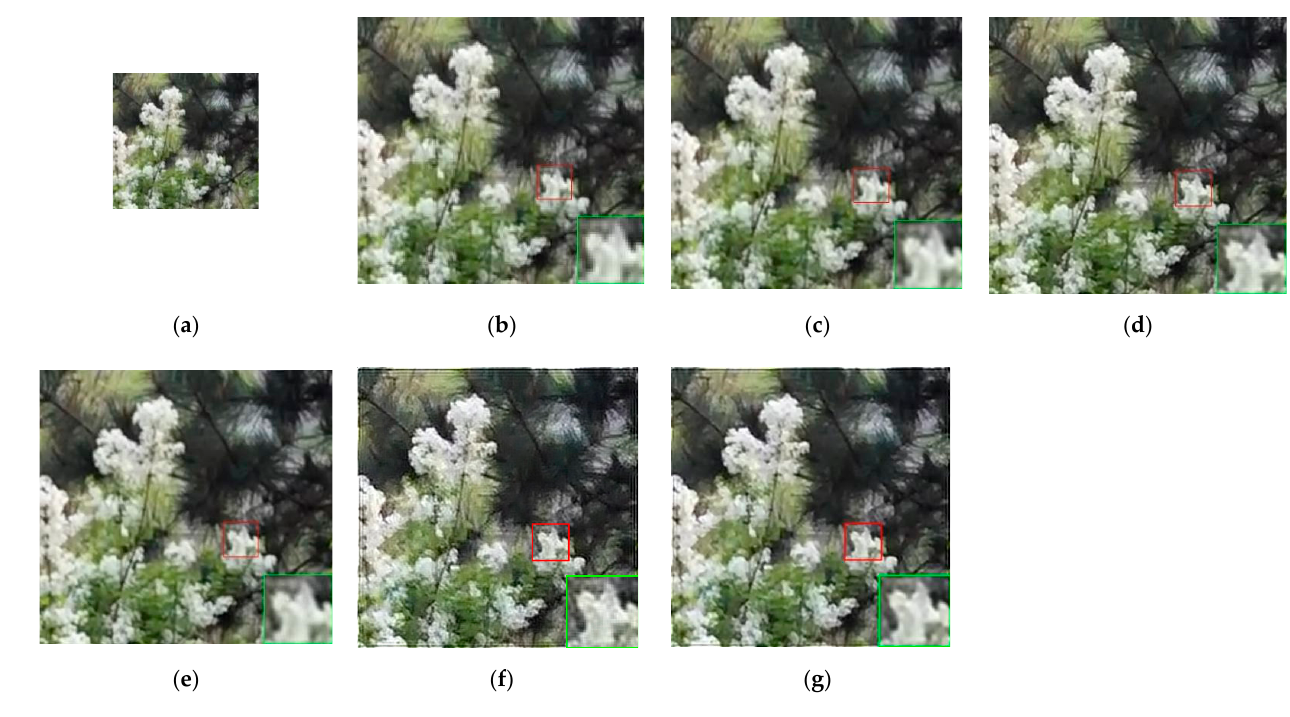
Figure 8. Visual comparison of algorithms for the IMG_1480 image when the magnification factor is 5. ( a ) The LR image; ( b ) Bicubic interpolation; ( c ) BayesSR; ( d ) SRB; ( e ) DeepSR; ( f ) FBSR; ( g ) Ours.